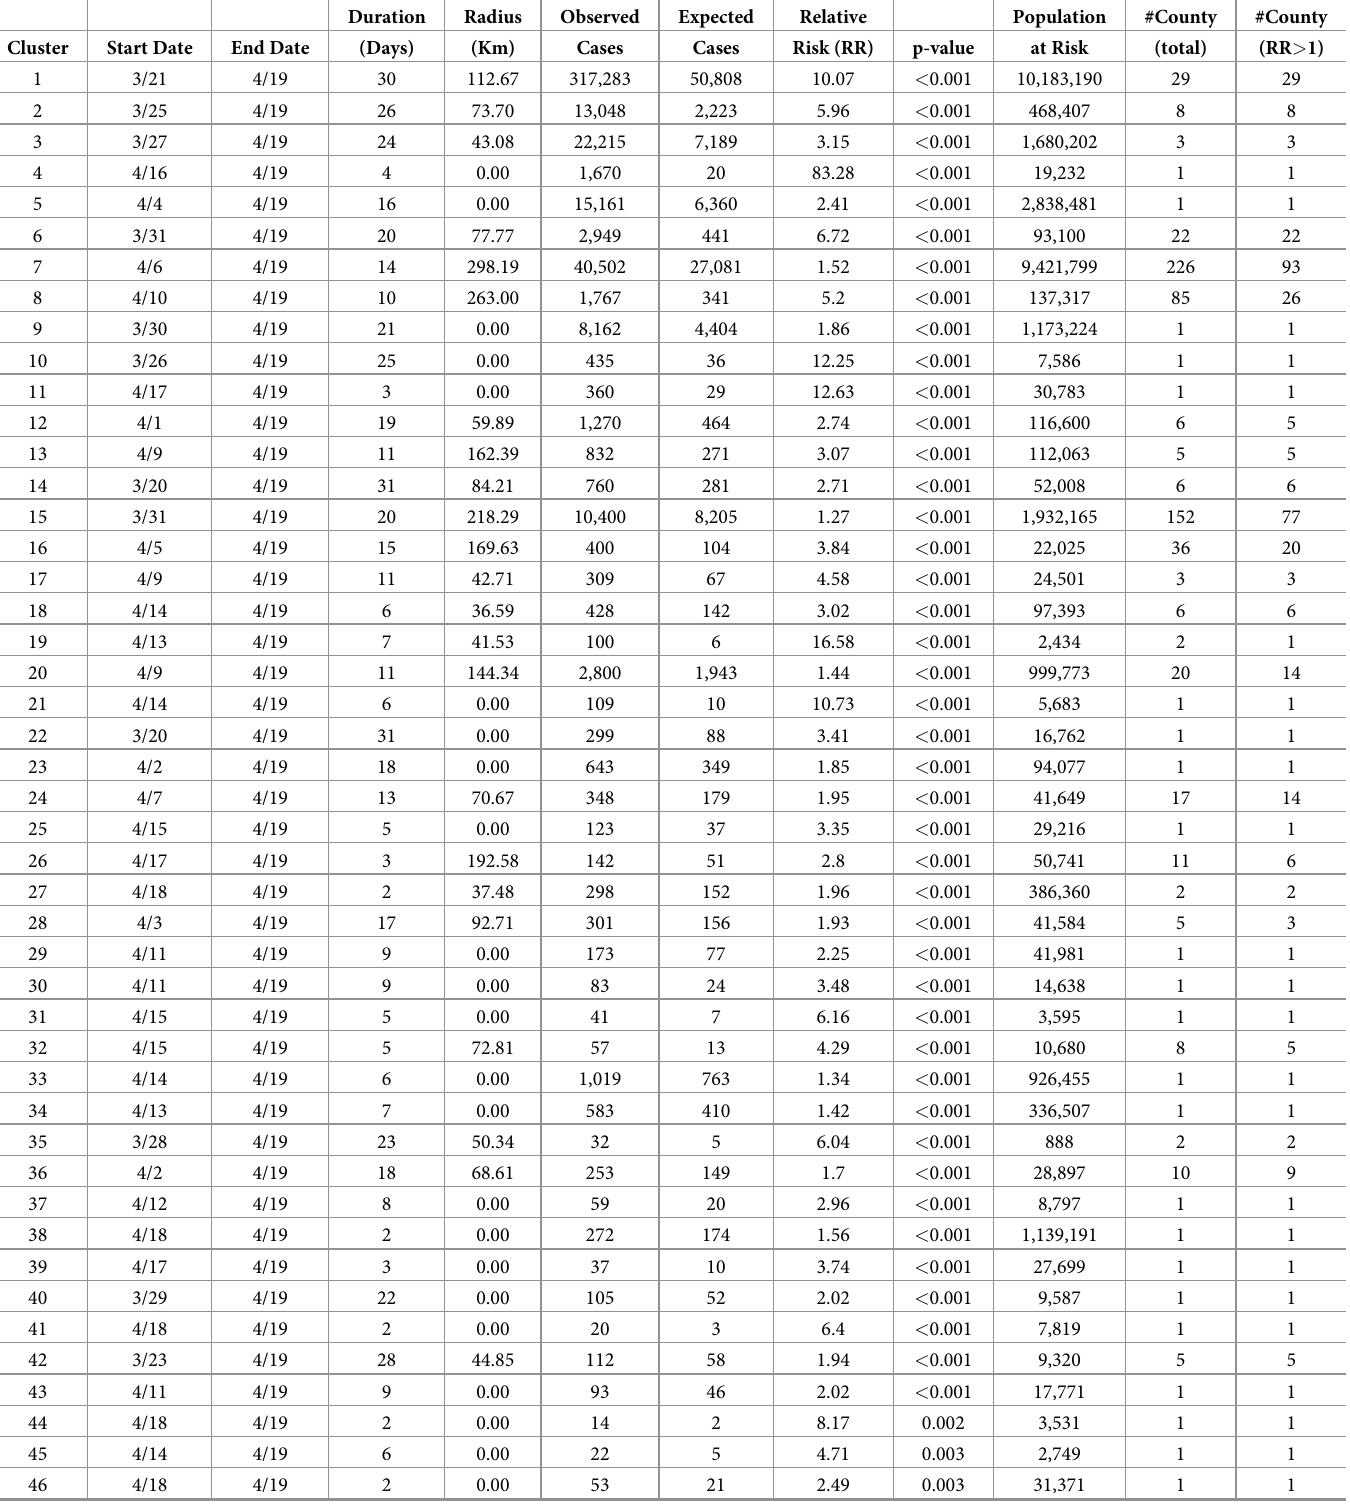
Table 3. Attributes of prospective space-time clusters (hotspots) for COVID-19 from 1/23-4/19/2020 at the county